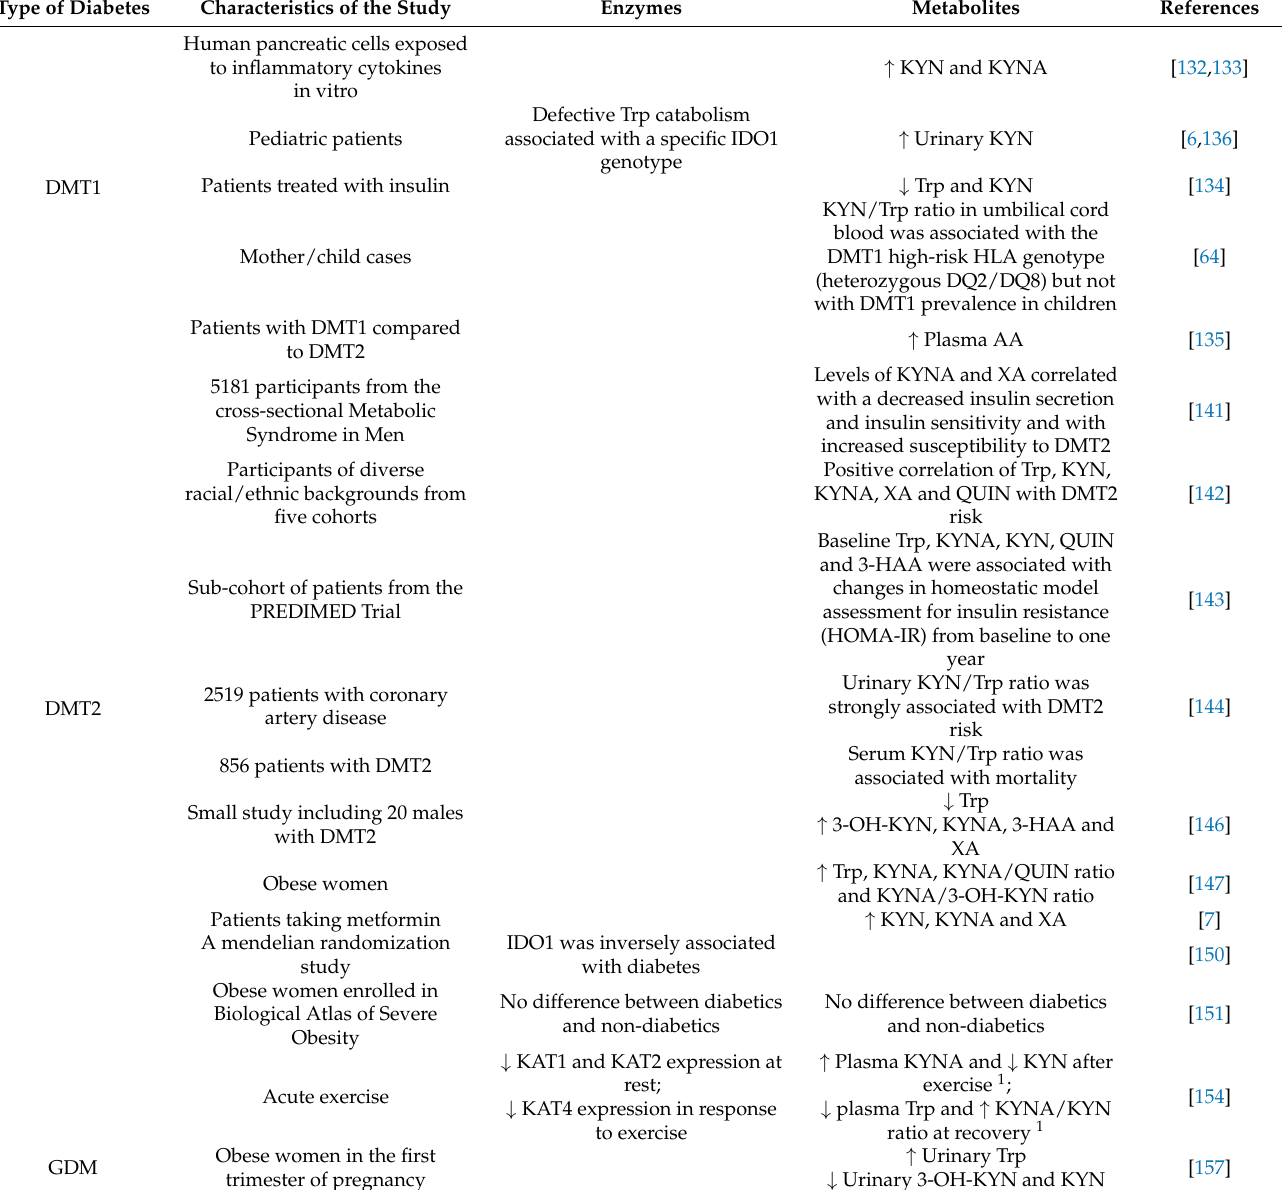
Table 3. Changes in enzymes and metabolites of the tryptophan–kynurenine pathway observed in human diabetes studies. 3-HAA: 3-hydroxyanthranilic acid; 3-OH-KYN: 3-hydroxykynurenine; AA: anthranilic acid; DMT1: diabetes mellitus type 1; DMT2: diabetes mellitus type 2; GDM: gestational diabetes mellitus; HLA: human leukocyte antigen; HOMA-IR: homeostatic model assessment for insulin resistance; IDO: indoleamine 2,3-dioxygenase; KATs: kynurenine aminotransferases; KYN: kynurenine; KYNA: kynurenic acid; QUIN: quinolinic acid; Trp: tryptophan; XA: xanthurenic